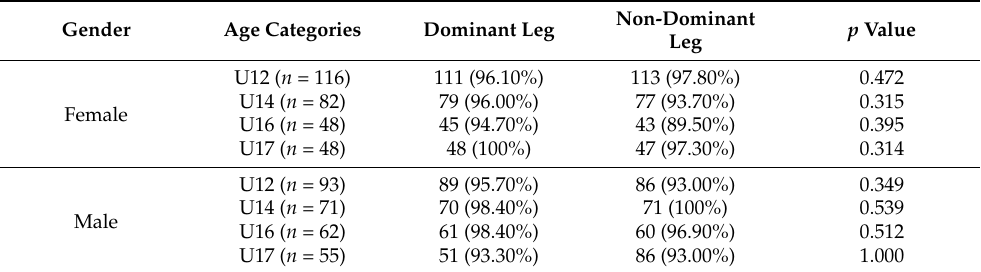
Table 3. Ankle instability for between-group comparisons of U12 to U17 basketball players.